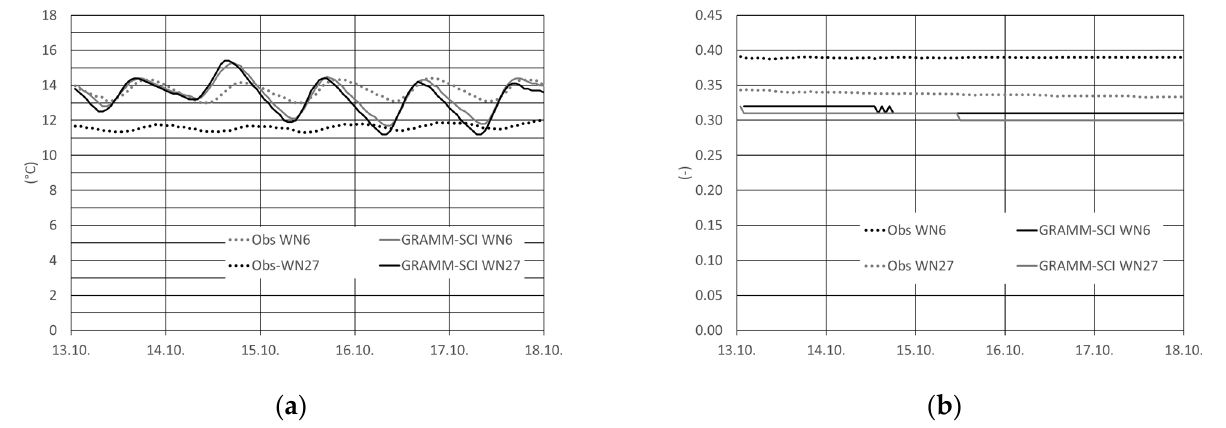
Figure 5. Observed and modelled soil temperatures ( a ) and soil-moisture contents ( b ) at selected sites in the Feldbach area.